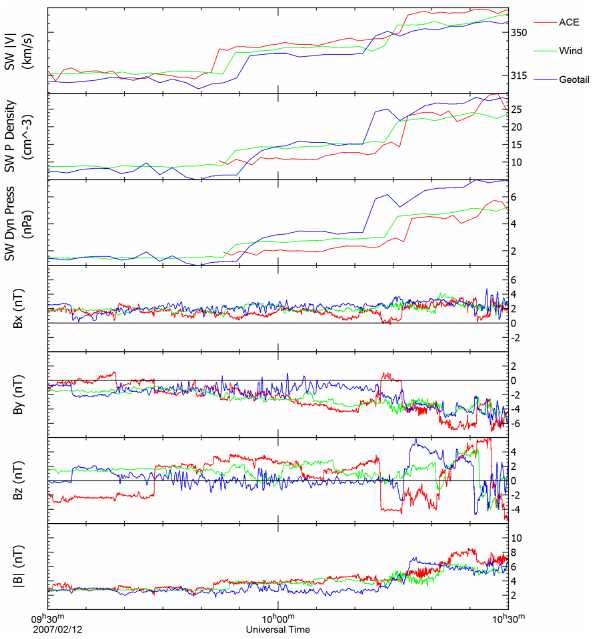
Figure 2. Solar wind and IMF conditions during the time inter- val 09:30–10:30UT: solar wind velocity, density and pressure mea- sured at ACE (red traces), Wind (green) and Geotail (blue) respec- tively are shown on the top three panels. Data from ACE and Wind are respectively lagged by 62 and 53min on both plots. These pa- rameters remained steady before 09:30UT, and then continuously increased over ∼ 3h afterwards. The IMF B X , B Y and B Z com- ponents in GSM and the magnitude of the field are shown on the bottom four panels; they show multiple orientation variations, while data from Wind suggest the IMF remains northward for most of the time. Geotail recorded h B Z i ≈ 0nT between 09:40 and 10:15UT, two significant southward excursions at 10:16 and 10:26UT, and mostly northward the rest of time. (See Sect. 4.1 for